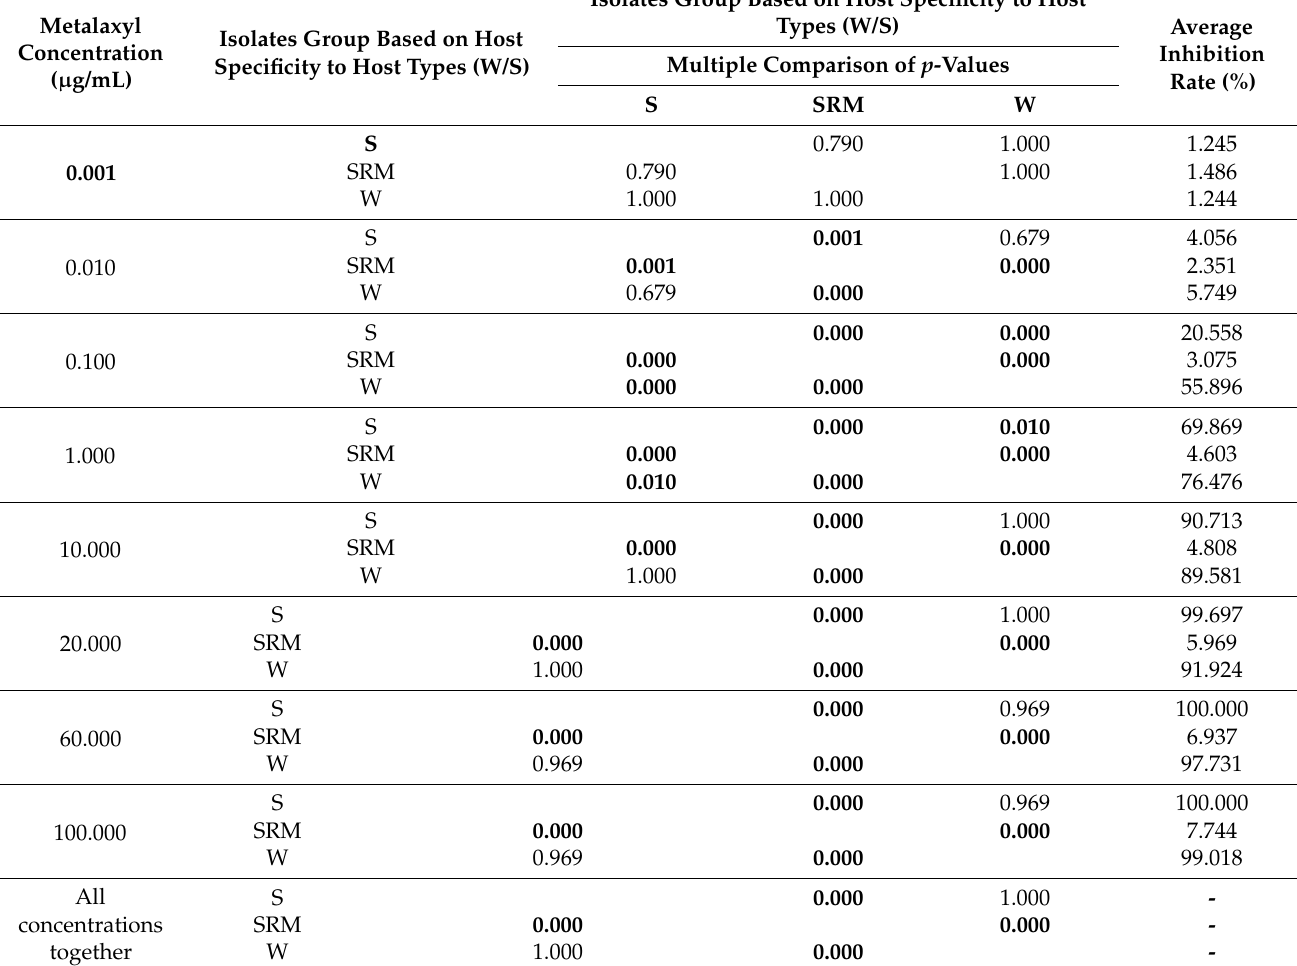
Table 4. Results of a multiple comparison of p -values of the Kruskal–Wallis test of P. cactorum growth inhibition caused by